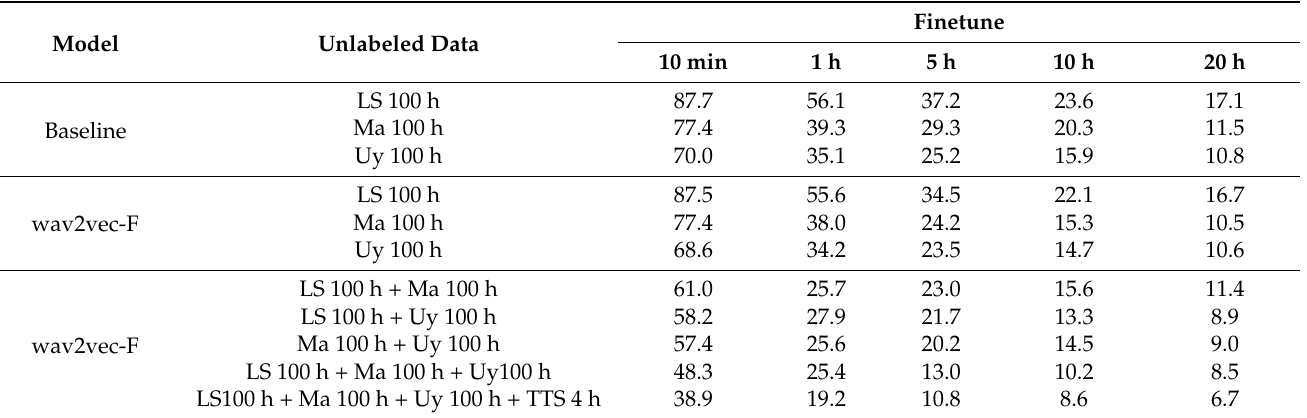
Table 6. Results of fine-tuning Kazakh data with different time settings when pre-training with different non-target language data as well as mixed